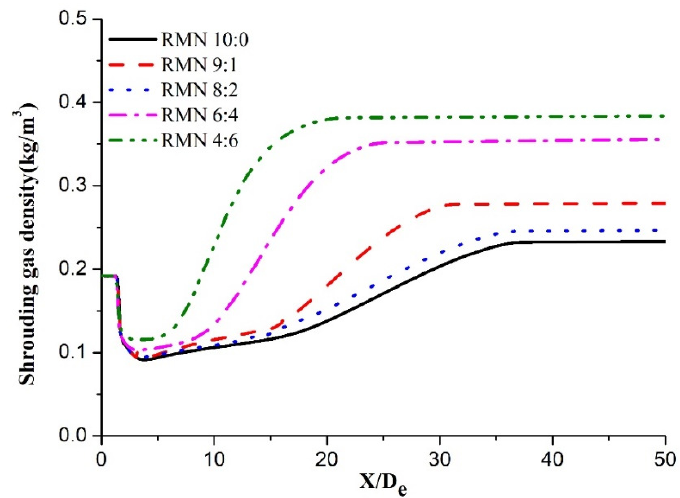
Figure 8. Shrouding gas density at y = D e for various